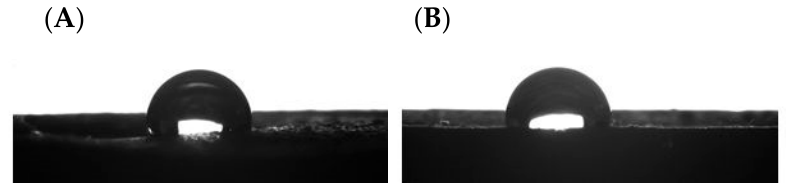
Figure 17. Droplets applied on the bottom part of the dumbbells for samples containing 70% vol. ( A ) with non-degassed base diatoms, and ( B ) with non-degassed fractionated